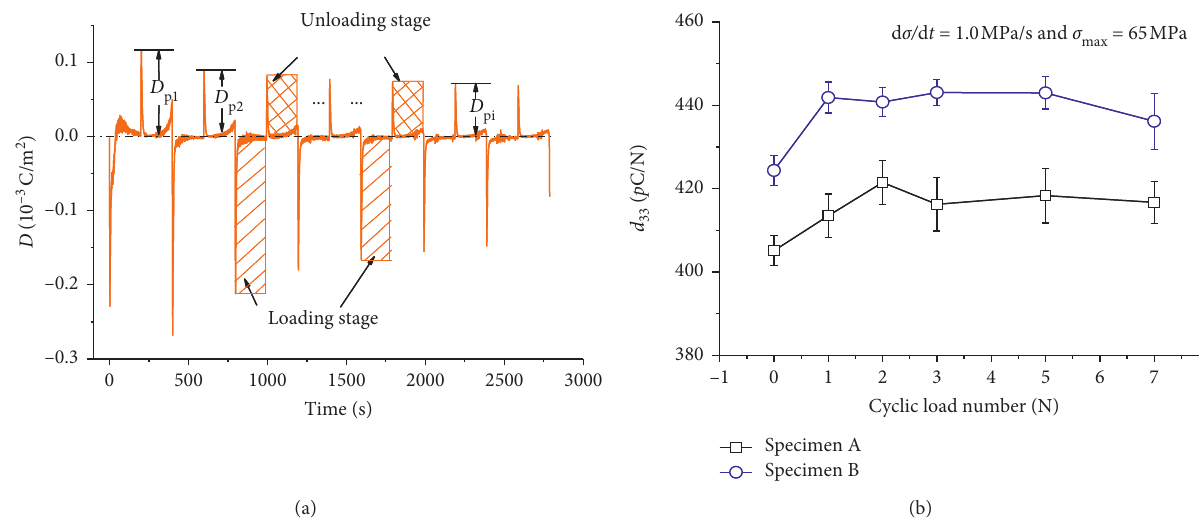
Figure 7: Schematic of (a) the electrical displacement versus with time and (b) d